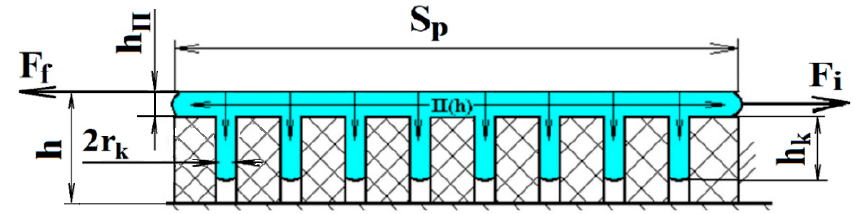
Figure 2. Model of fixing the polymer layer on the fabric.